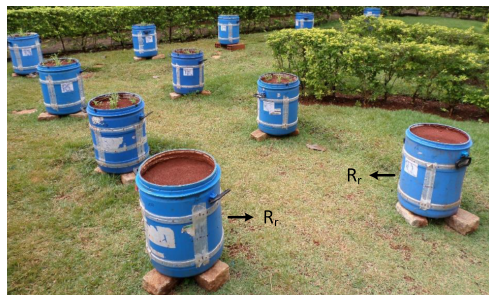
days of laboratory cultivation. ×